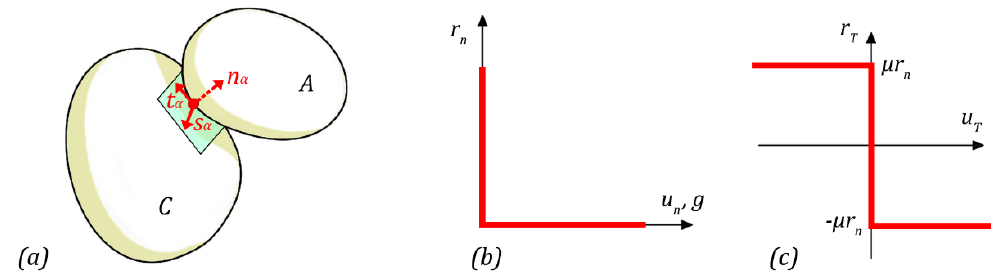
Figure 6. ( a ) Contact between two bodies, ( b ) Signorini’s condition and ( c ) Coulomb’s friction law.